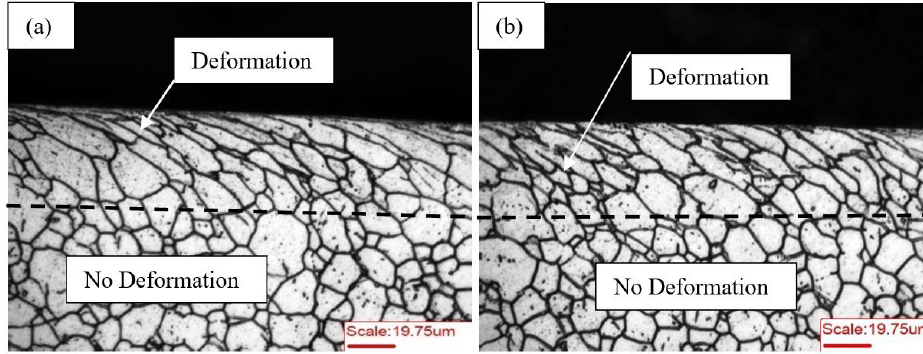
Figure 10. Sample Tests 3 (a) machined and (b) machined and polished. Electrolytic attack with 60% HNO